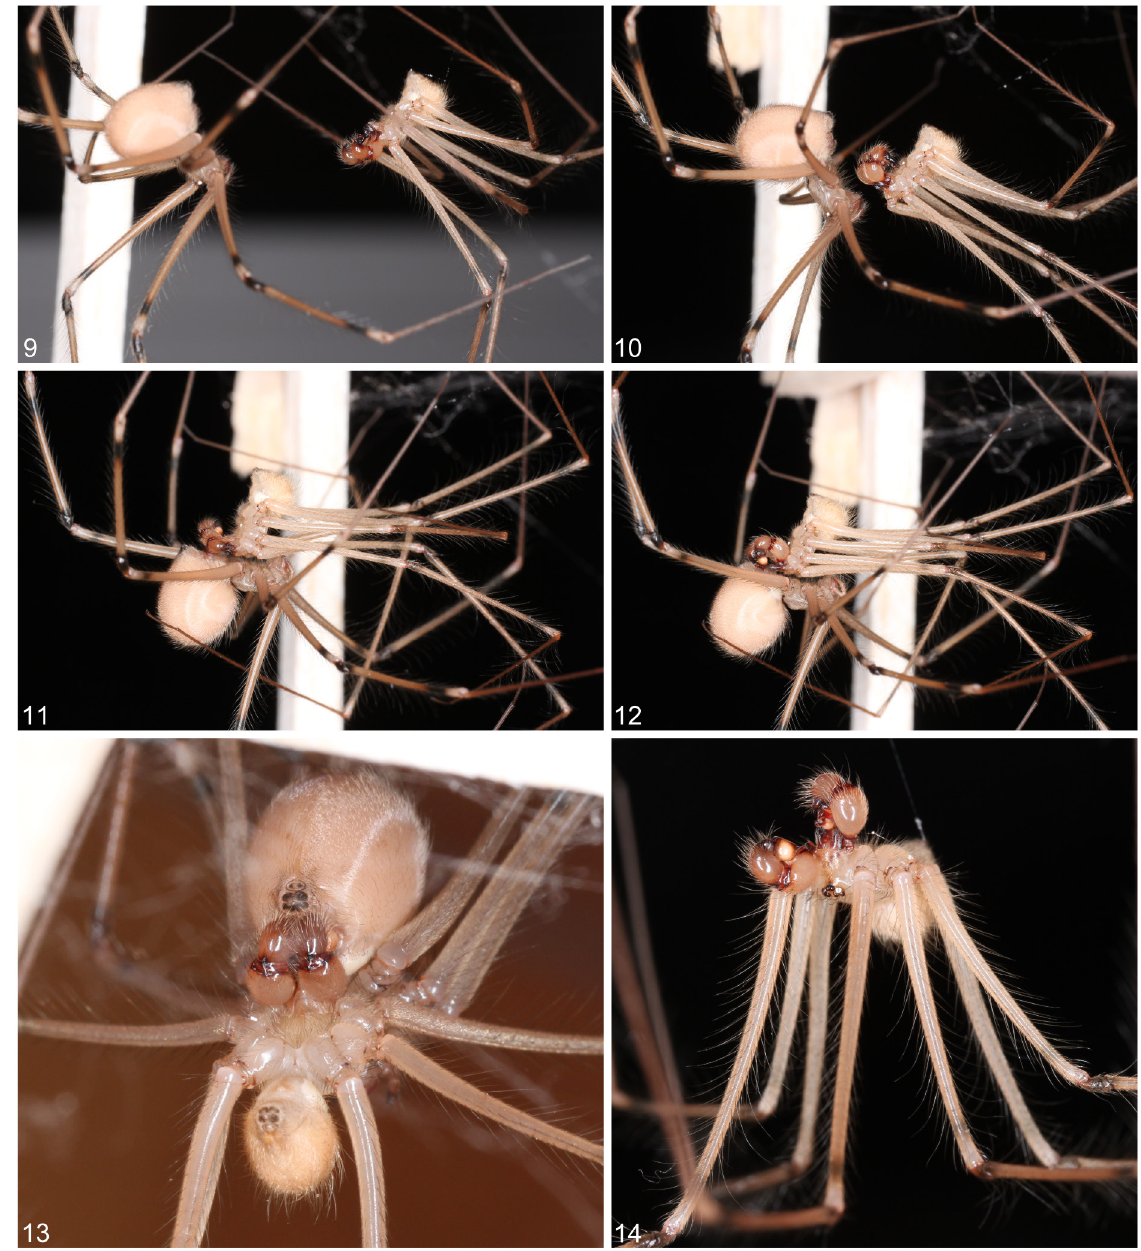
Figs 9–14. Mating sequence of Artema nephilit sp. nov. 9 . Male (on the right) approaches female and touches female legs. 10 . Male lowers palps below body for final approach. 11 . Male searches for correct position on female, female abdomen is pushed backwards. 12 . Male rotates palps into final mating position (180° around longitudinal axis; note that the bulb is visible). 13 . Asymmetric insertion of palps (note that the male’s left palp is more deeply inserted than the right palp). 14 . Male cleans palps. Photos